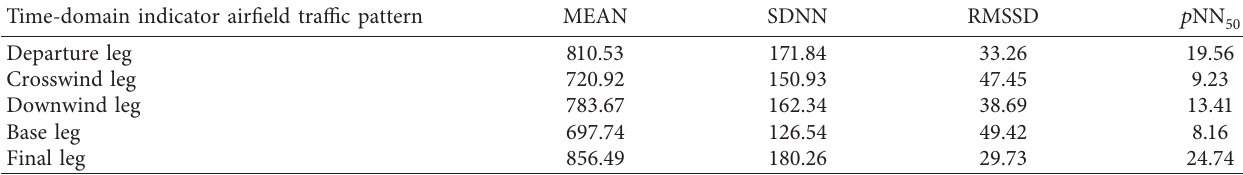
Table 3: HRV time-domain indicator on each side of the air field traffic pattern.